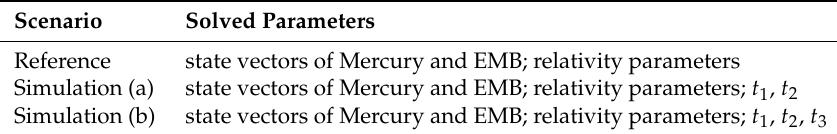
Table 2. Summary of the parameters solved in the least squares (LS) fit in each of the three scenarios described in the text.